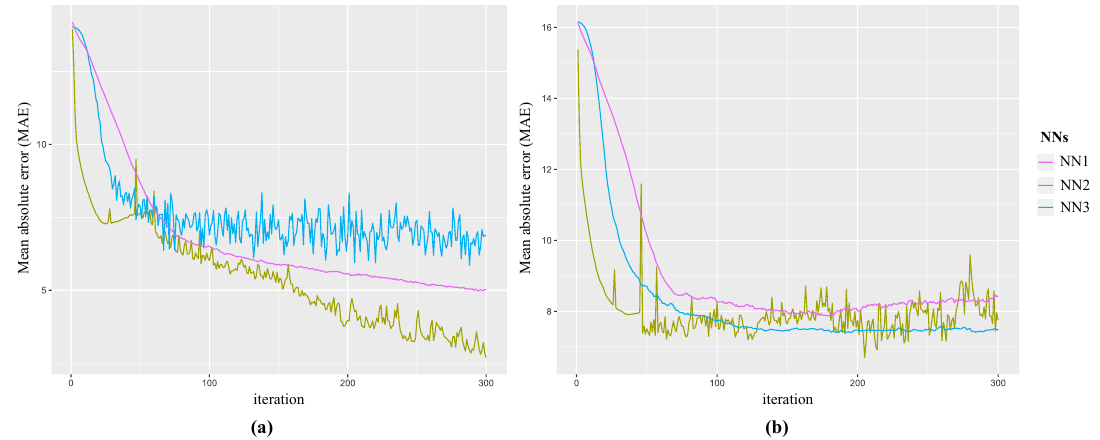
Figure 10. Mean absolute errors (MAE) of NNs for retrieving the canopy gap fraction (%) from SAR backscatter: ( a ) Training errors. ( b ) Validation errors.